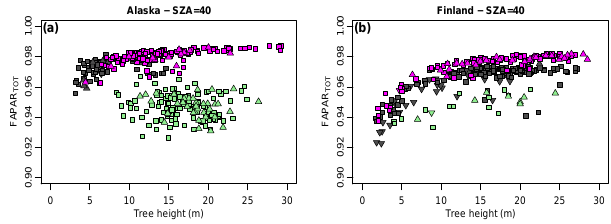
Figure 6. FAPAR TOT as a function of tree height at SZA of 40 ◦ . The figures show only monospecific plots, i.e., plots in which the basal area proportion of one of the species exceeded 80%. For ex- planation of the symbols, see legend in Fig. 4.